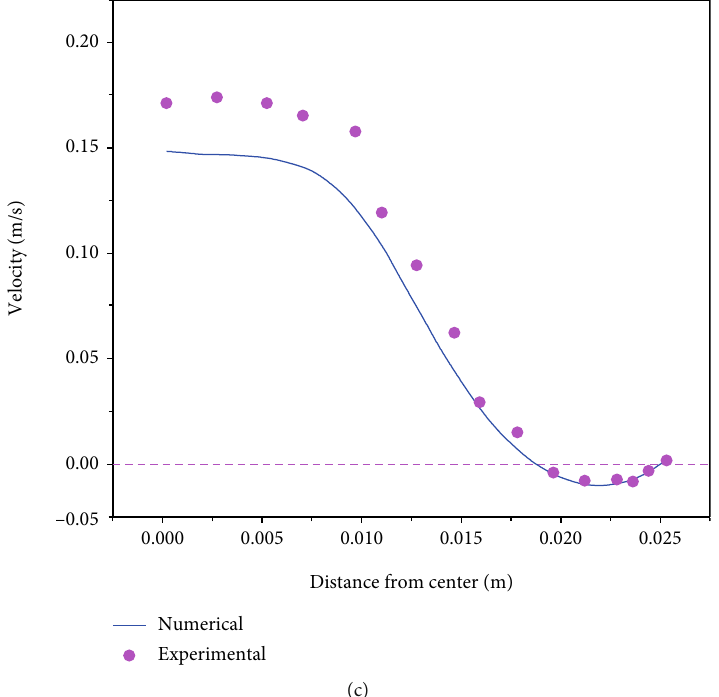
Figure 4: Velocity pro fi le at a distance of (a) 1D from the stenosis throat, (b) 1.5D from the stenosis throat, and (c) 2.5D from the stenosis